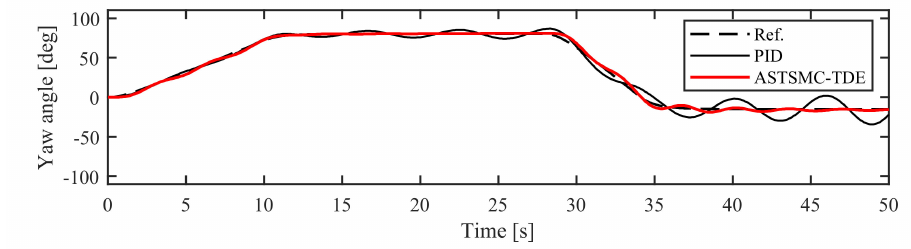
Figure 12. Simulation results of the yaw angle trajectory tracking in AM mode.